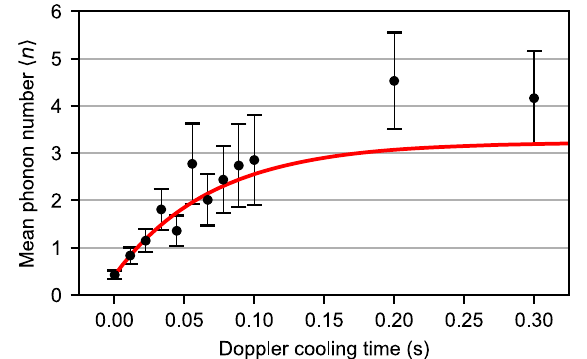
FIG. 4. Heating of the y WCR mode out of the ground state during the Doppler cooling pulse applied to the Be þ ion (black points), with the expected background from anomalous heat- ing removed. The data are fitted (red line) using a semi- classical